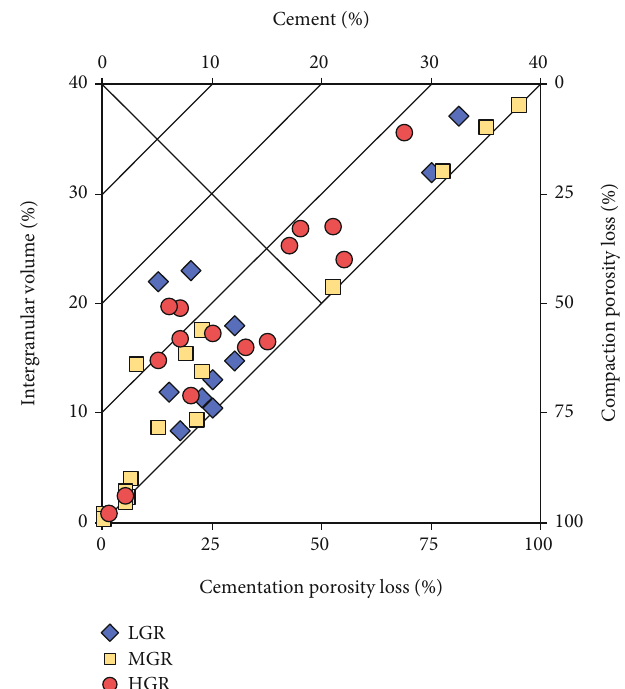
Figure 7: The intergranular volume-cement diagram for evaluation of relative importance of compaction and cementation to porosity loss of sandstone samples in di ff erent geothermal gradient regions.